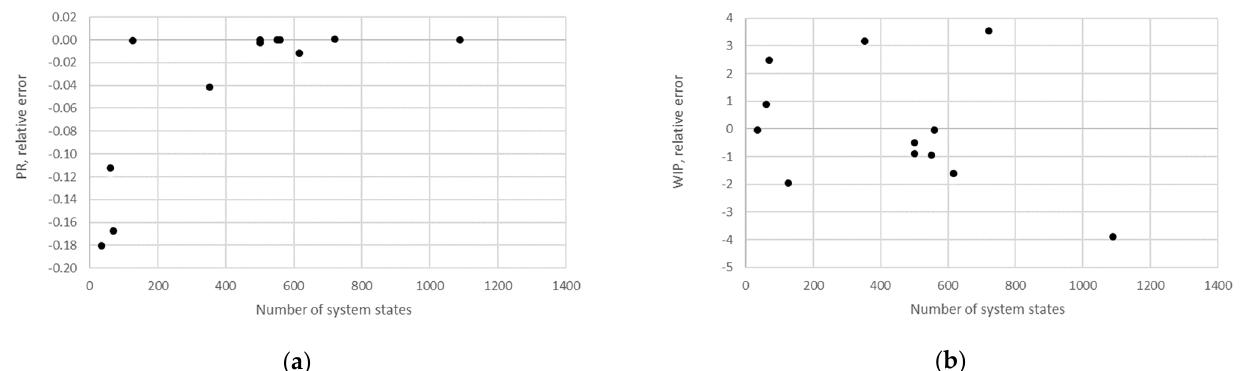
Figure 22. M = 3, relative error obtained using the numerical method—( a ) PR and ( b ) WIP.